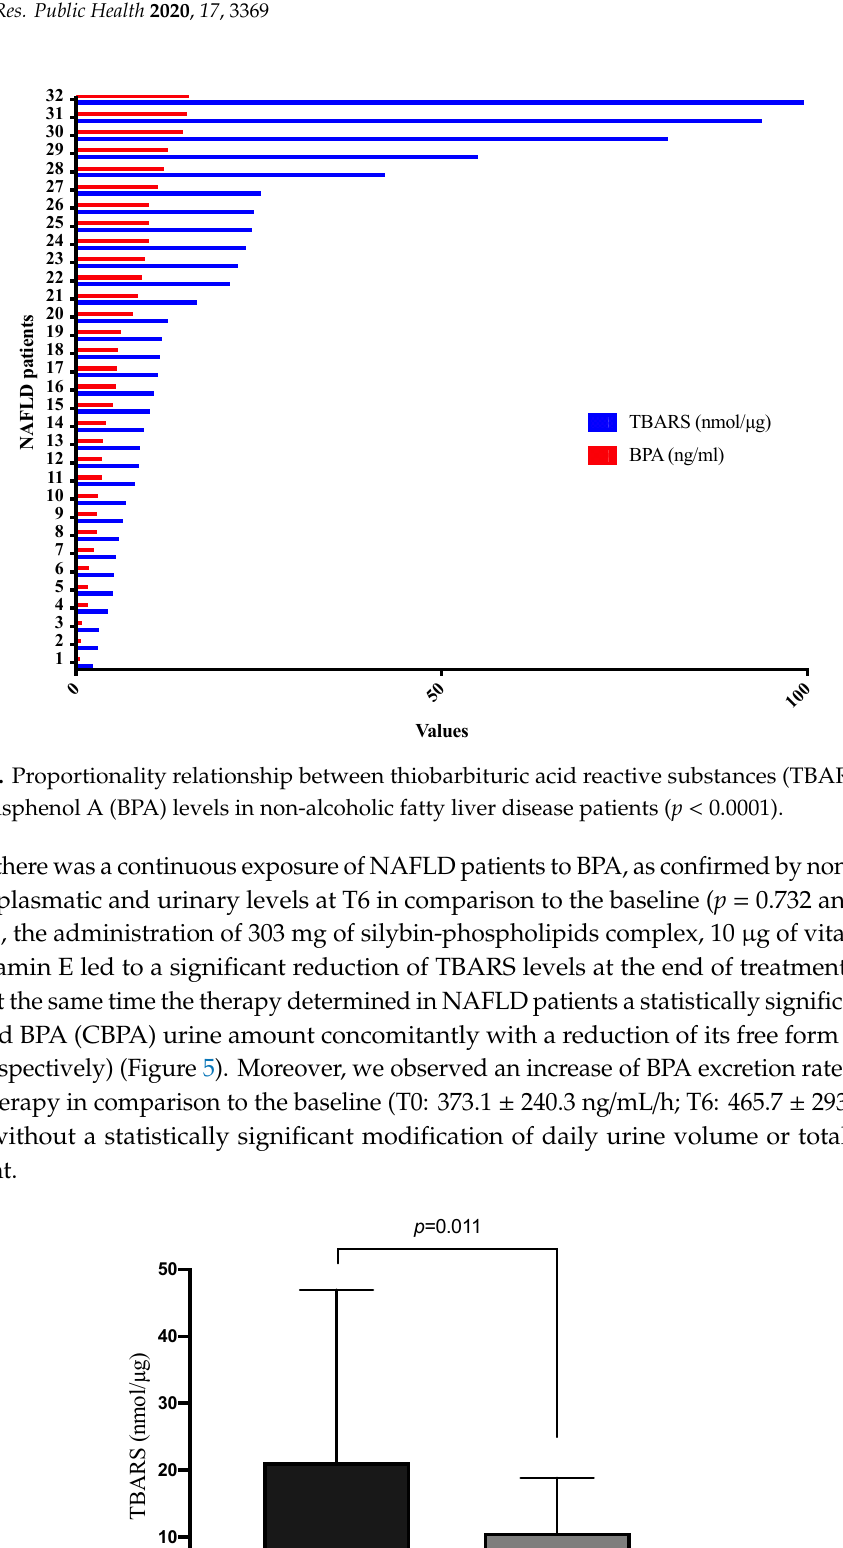
Figure 5. Free bisphenol A (BPA) and conjugated bisphenol A urine levels at the baseline and after six months of silybin with phospholipids and vitamin D (RealSIL 100D) administration ( A : p = 0.0002; B : p < 0.0001 respectively).